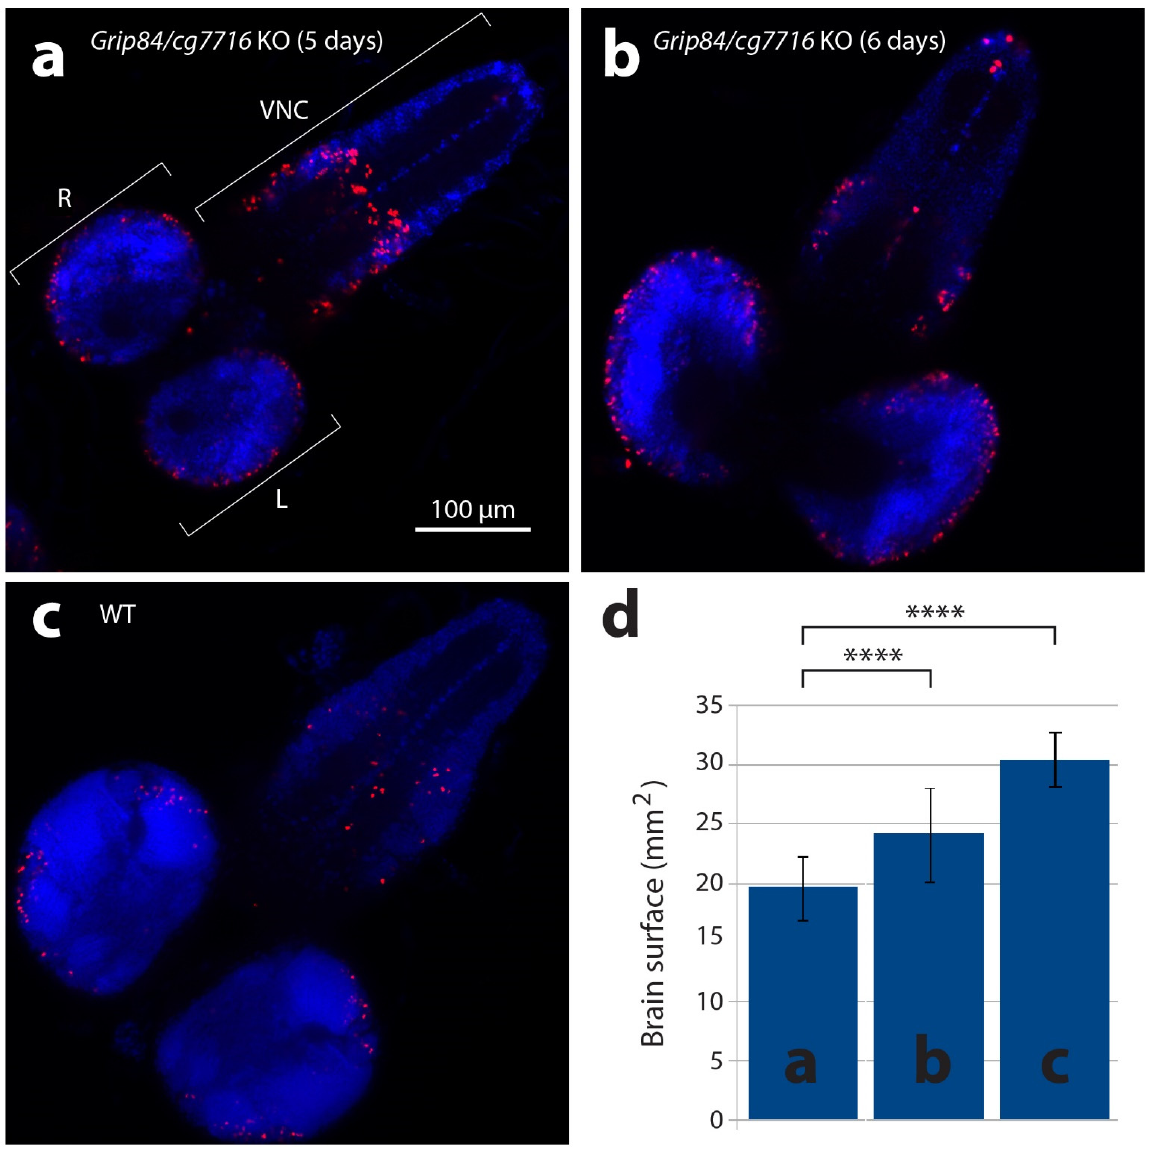
region of the normal cuticle on the abdomen. ( d ) Pharate adult female fly, Df(1)14.4 ; Dp(1;3)DC364; pulled out of the pupal case, shown from dorsal view and ( e ) ventral view. The abdominal pigmented cuticle is completely absent. Yellow arrowheads point at the bases of four bristles on the notum in the WT female fly; ( b ) in the mutant female fly, ( d ) only one bristle is left. In the mutant female, one of the legs is incorrectly developed (( e ) arrow); in some cases partial leg duplications were observed for the same genotype ( f ). A wild type eye from panel a is magnified in ( g ), showing the characteristic, hexagonal structure, which is absent in Df(1)14.4 ; Dp(1;3)DC364 flies ( h ).